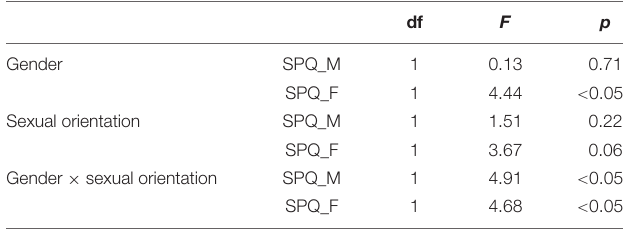
TABLE 6 | Between-subject effects on the feminine and masculine subscales of the